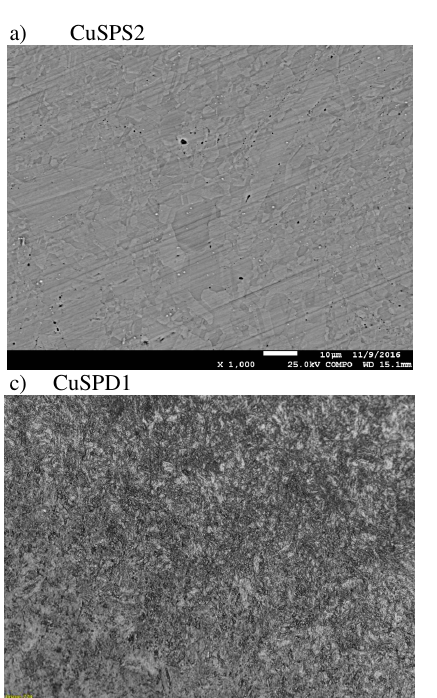
Fig. 7: SEM observations of the SPS materials (a and b) and optical microscopy observations of SPD materials (c and